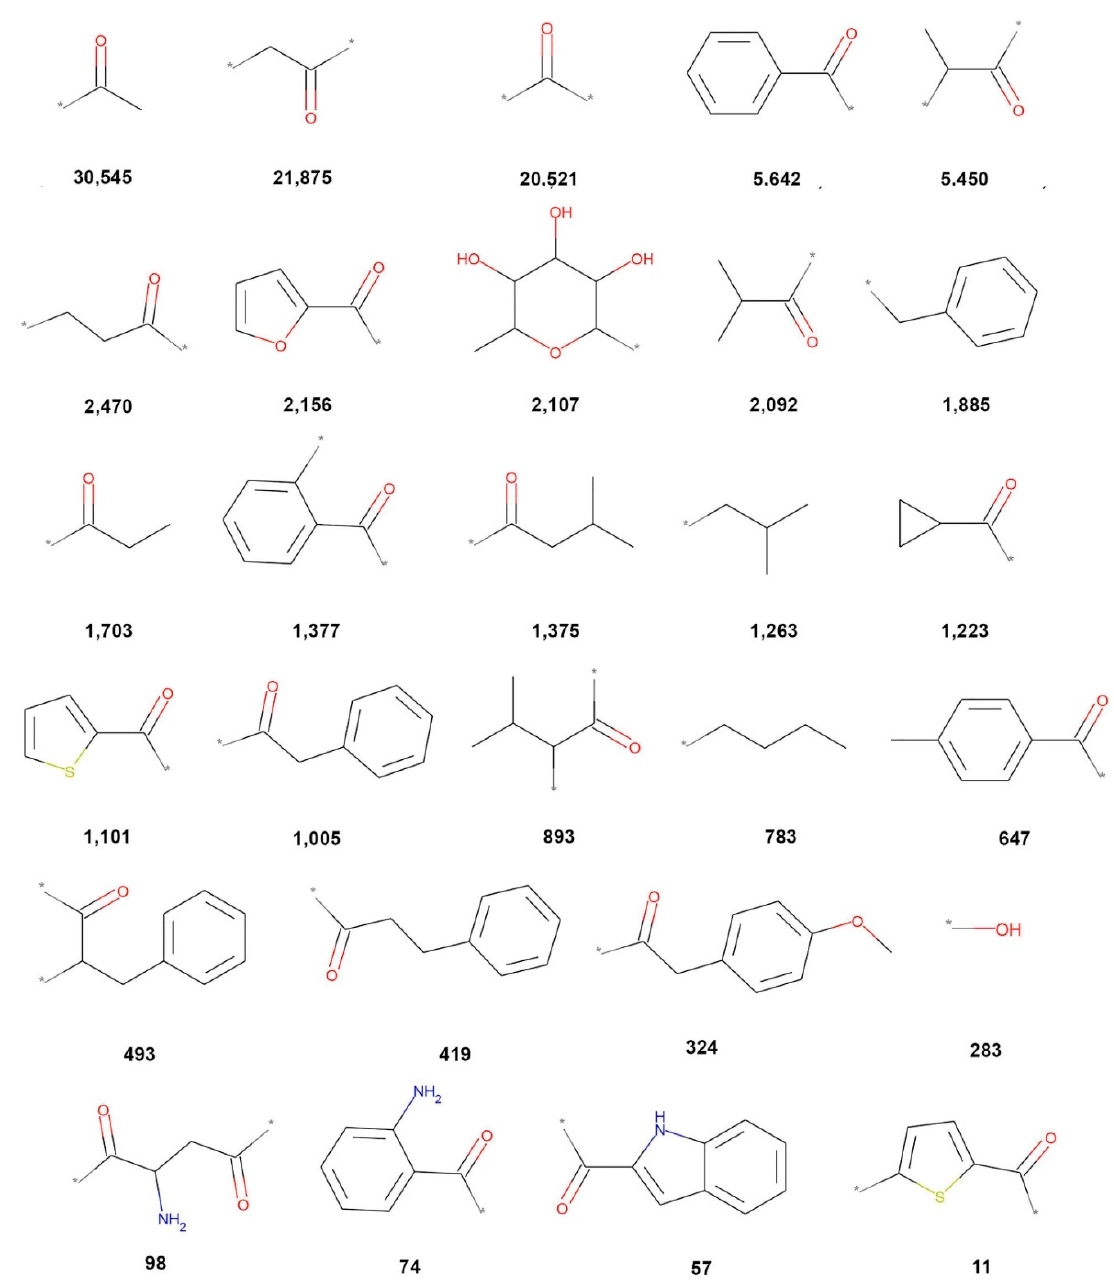
Figure 7. Overlapping fragments between COCONUT, FooDB, DCM, CAS, and 3CLP. The sum of frequencies of each fragment in all databases is indicated in bold font.